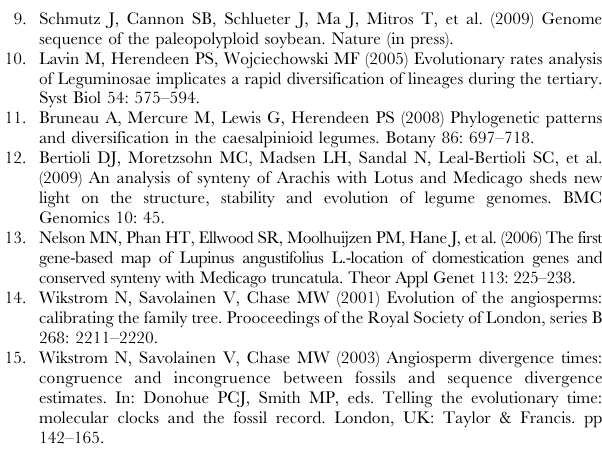
File S2 Alignments and trees. Trimmed alignments and trees for all 1249 trees described in the